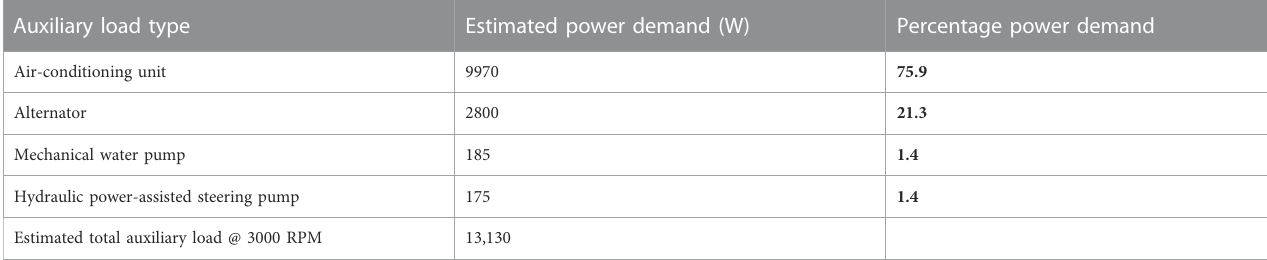
TABLE 5 Summary of engine auxiliary power